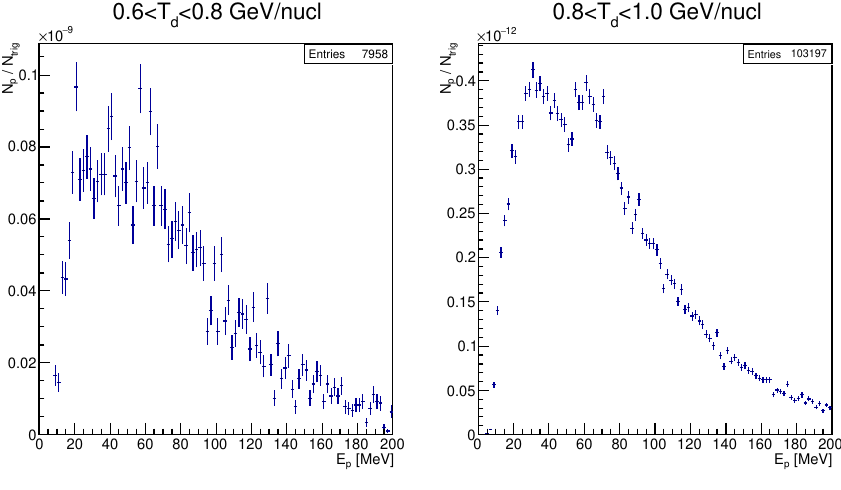
Figure 3. Energy spectrum of secondary protons. The minimal energy of deuteron beam for η -nuclei production is 0.8 GeV /